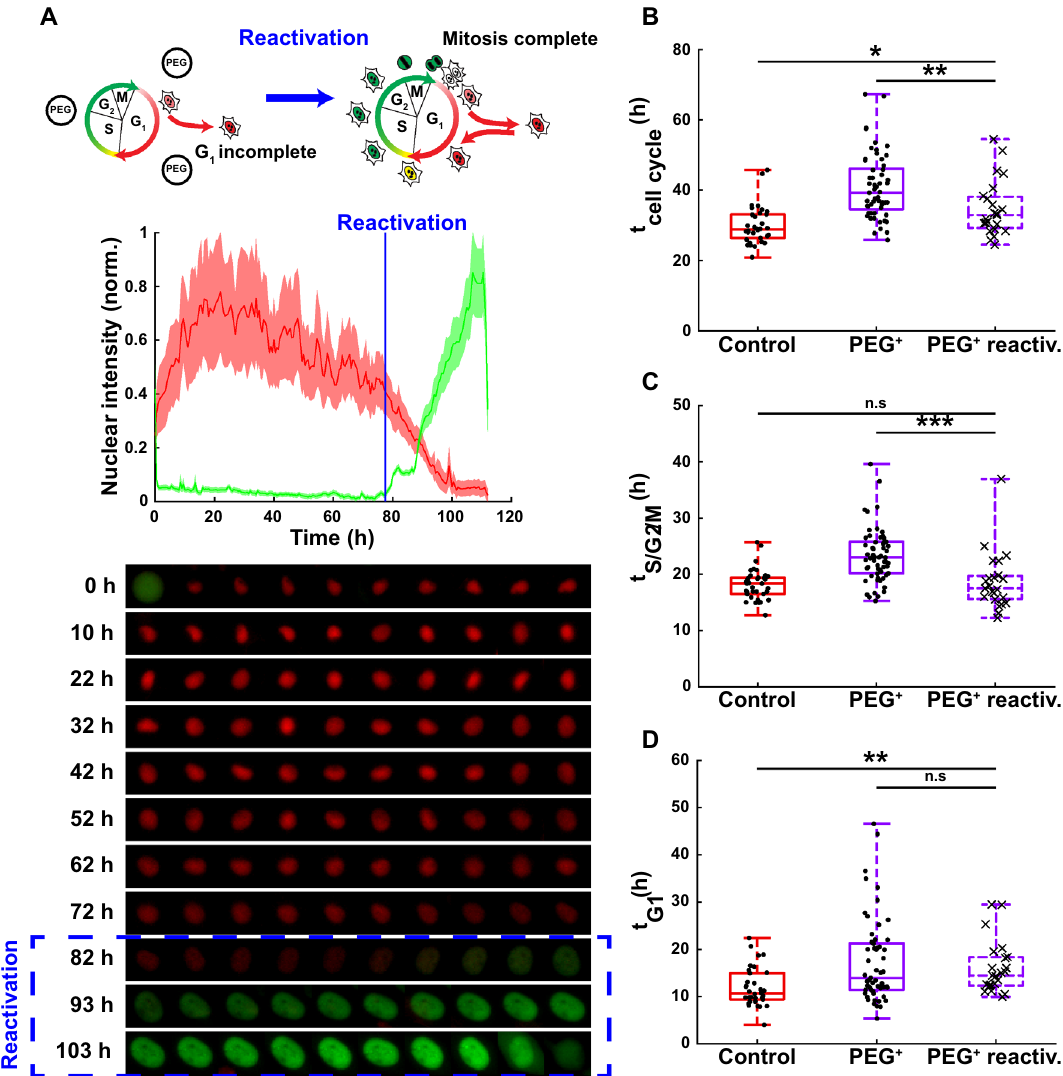
Figure 6. Reactivation and return to regular single cell cycle dynamics of previously delayed or growth arrested human metastatic cells upon releasing the osmotic stress. ( A ) Cartoon of the effect of reactivation on single cell cycle dynamics (top panel), normalized FUCCI2 fluorescence intensity (middle panel), with corresponding fluorescence images before and after reactivation (bottom panel). ( B ) Duration of the whole cell cycle (time from division to division) for the cell subpopulation “Mitosis complete”, before and after reactivation (N = 34, 57 and 23 cells for the control (red), PEG + (violet) and PEG + reactiv. (dashed box), respectively). ( C ) Duration of the S/G2/M phase for the cell subpopulation “Mitosis complete”, before and after reactivation (N = 39, 61 and 23 cells for the control (red), PEG + (violet) and PEG + reactiv. (dashed box) groups, respectively). ( D ) Duration of the G1 phase for the cell subpopulation “Mitosis complete”, before and after reactivation (N = 34, 57 and 23 cells for the control (red), PEG + (violet) and PEG + reactiv. (dashed box) groups, respectively). The plots represent the median, 1st and 3rd quartiles and extrema. Statistical analysis with respect to PEG + reactiv. using a one- tailed Wilcoxon rank sum test, n.s: p > 0.05, *: p < 0.05, **: p < 0.01 and ***: p < 0.001. The FUCCI2 cartoons were adapted from Sakaue-Sawano et al. 22 , Copyright (2008), with permission from